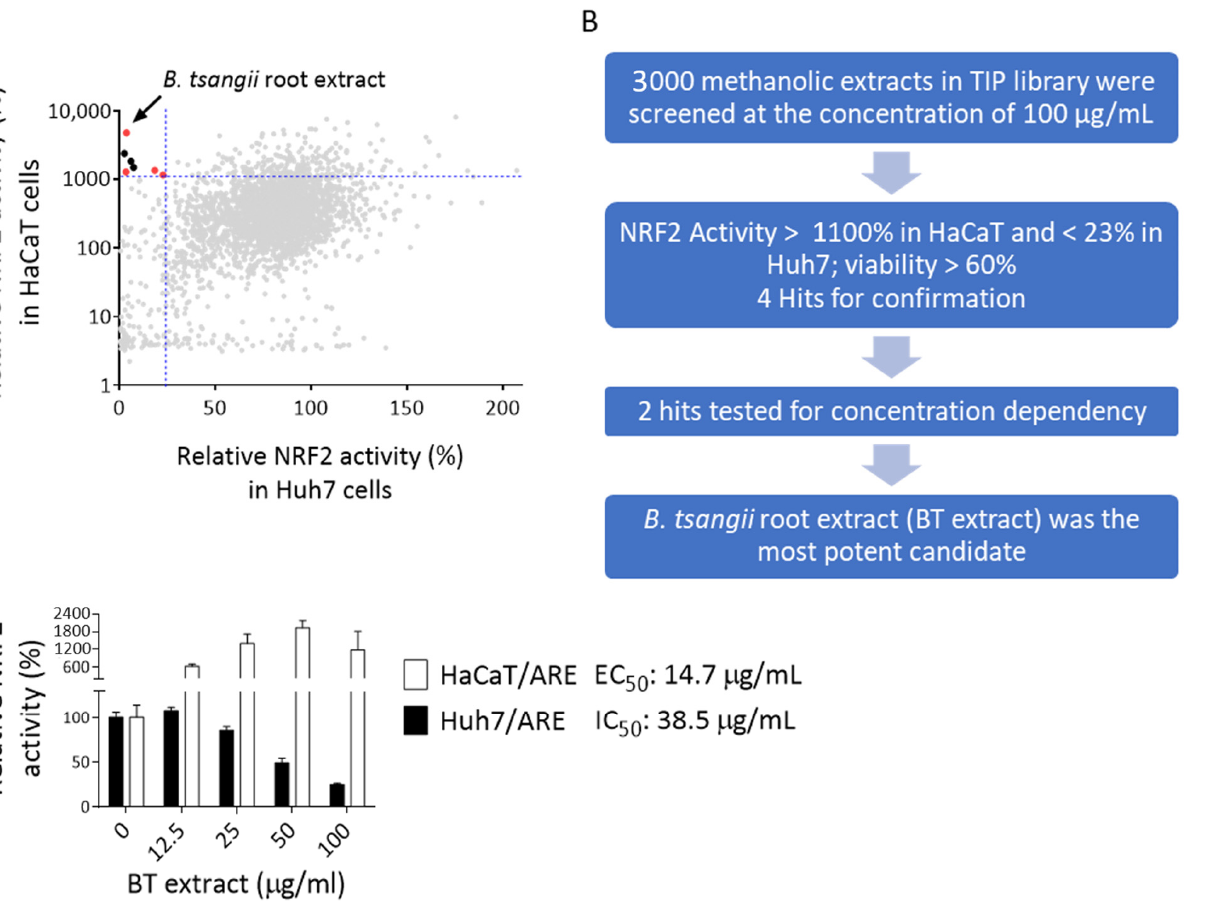
Figure 2. Identification of Beilschmiedia tsangii root extract as a selective NRF2 regulator. ( A ) The XY scatterplot shows the distribution of relative NRF2 activity in primary screening. Extracts that induced NRF2 activity to >1100% (horizontal dashed line, which was approximately equivalent to mean + 1SD of all tested extracts) in HaCaT/ARE cells and reduced NRF2 activity in Huh7/ARE cells to <23% (vertical dashed line, which was approximately equivalent to mean—2SD of all tested extracts) without severe cytotoxicity (>60% of DMSO control wells) were selected as hits of the primary screen (red dots). The screening results of Beilschmiedia tsangii root extract (BT extract) are indicated. ( B ) Screening flowchart for the identification of selective regulators of NRF2. ( C ) Huh7/ARE and HaCaT/ARE cells were treated with indicated concentrations of BT extracts for 24 h. NRF2 activity was calculated as described in Figure 1D.